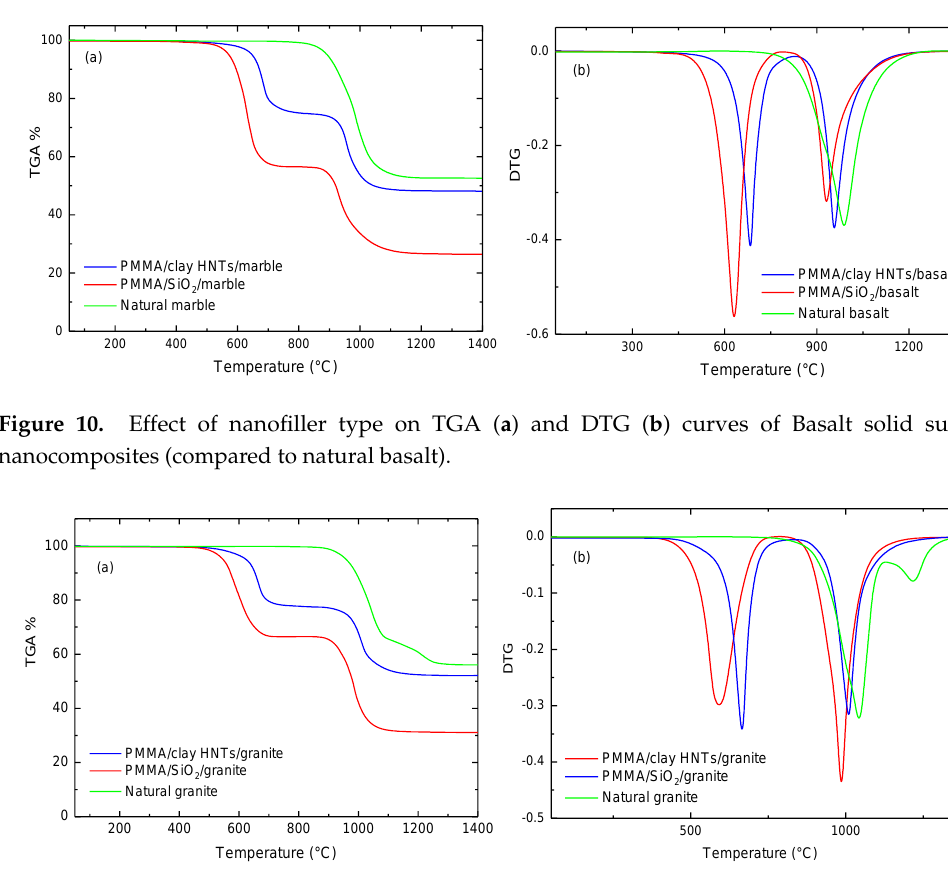
Figure 11. Effect of nanofiller type on TGA ( a ) and DTG ( b ) curves of Granite solid surface nanocomposites (compared to natural granite).